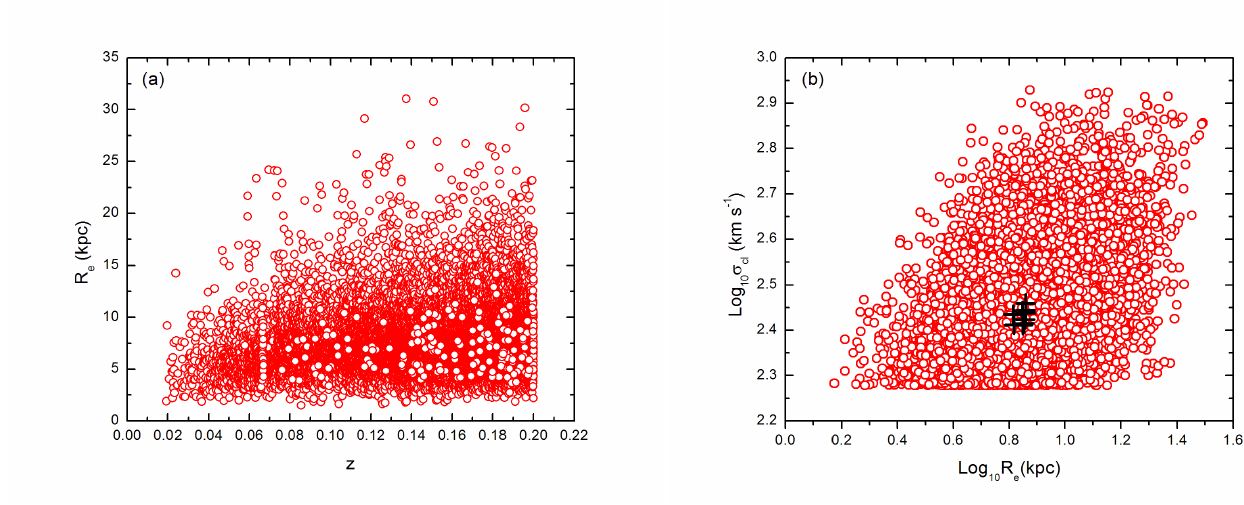
Fig. 3 BCGs r -band effective radii ( R e ) with (a) redshift and (b) σ cl of host clusters and groups. Error bars represent the average values of σ cl in every R e bin with